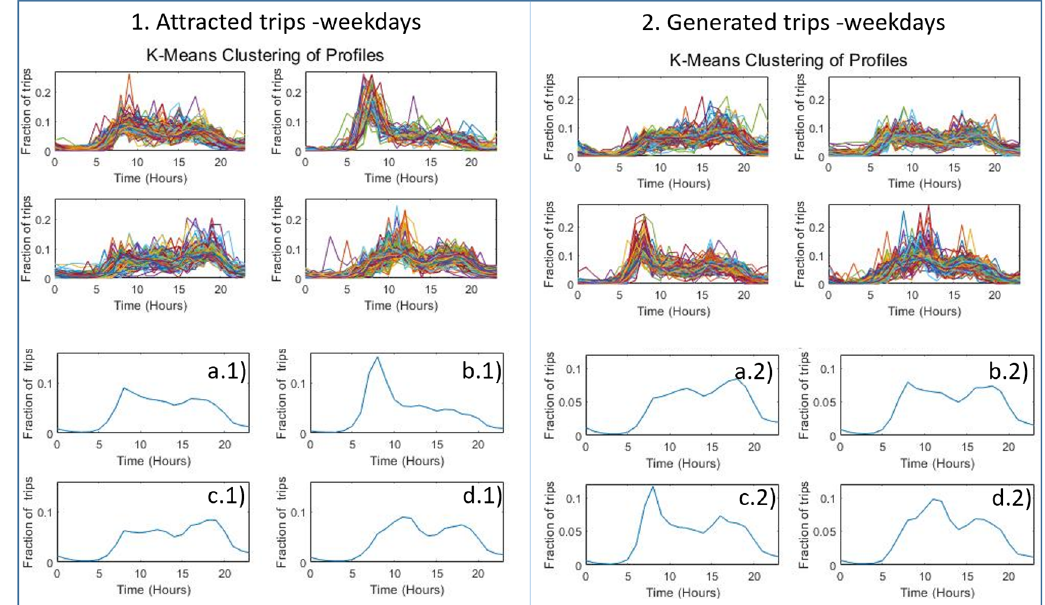
Figure 7. K-means clustering applied to ( 1 ) attracted trips and ( 2 ) generated trips on the weekdays. Resulting clusters: mixed-use ( a1 , b2 ), business/industrial ( b1 , a2 ), residential ( c1 , c2 ), and commercial ( d1 , d2